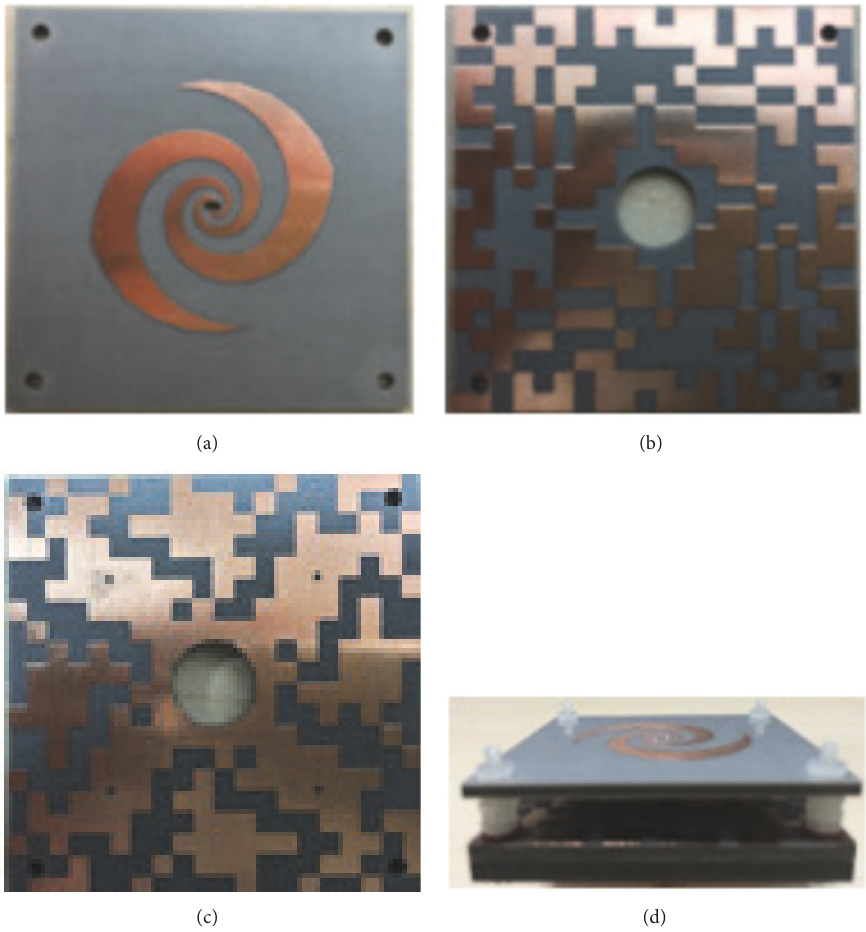
Figure 12: (a) Equiangular spiral antenna, (b) parasitic layer 1, (c) parasitic layer 2, and (d) side view of Ant2.